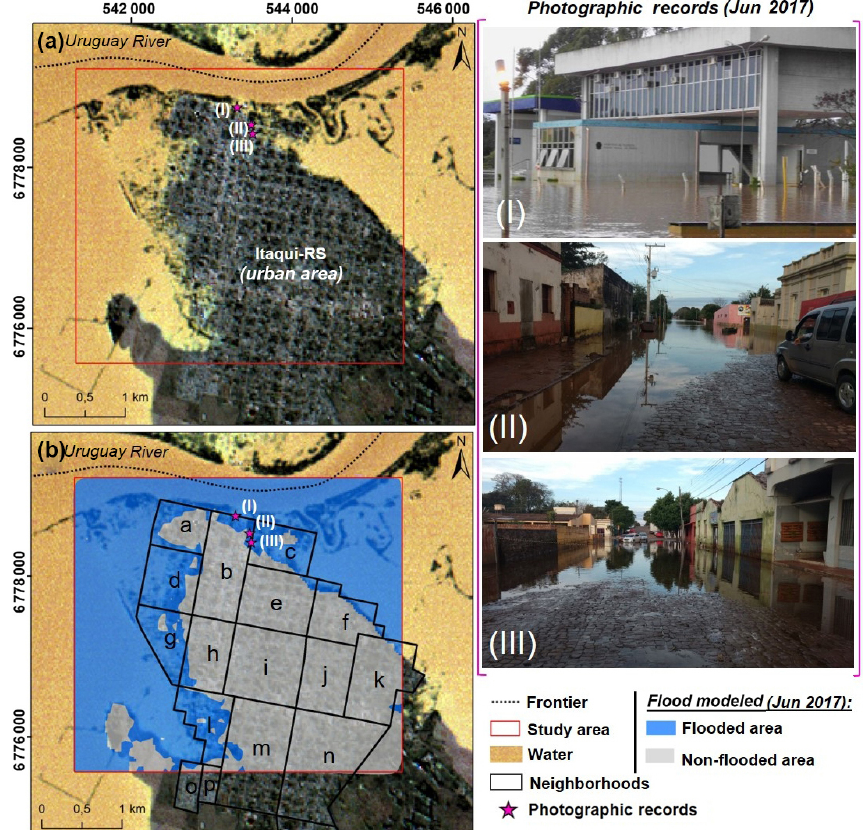
Figure 10. The 2017 historical flooding of the Uruguay River basin: (a) CBERS-4 MUX satellite image showing the extent of the floods in the Itaqui city area on 12 June 2017 (hybrid color composition: RGBI-765NDWI); and (b) simulated flood event in Itaqui for the same satellite imaging date. Neighborhoods: (a) Cerrinho Dois Umbus; (b) Centro; (c) Ponte Seca; (d) Varzea; (e) Cidade Alta; (f) Cohab; (g) Enio Sayago; (h) Estacao; (i) Capelinha; (j) Dr. Ayub; (k) Jose da Luz; (l) Vinte e Quatro de Maio; (m) Chacara; (n) Cafifas; (o) Vila Nova; and (p) Uniao. Photographic records: (I) the Federal Revenue Customs Building; (II) Osvaldo Aranha street (Silva, 2017); (III) Borges do Canto street (Silva,